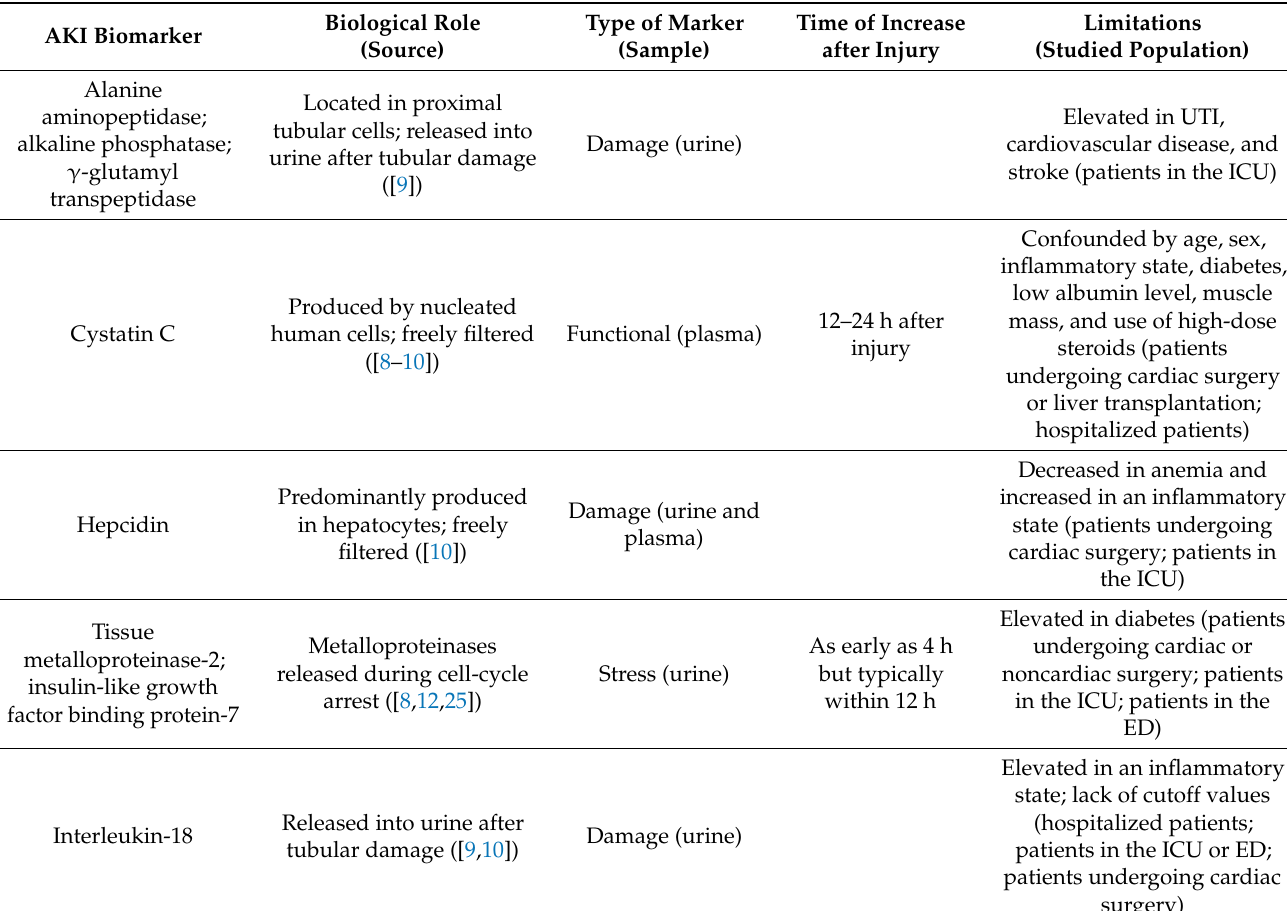
Table 1. Biomarkers of AKI (adapted from